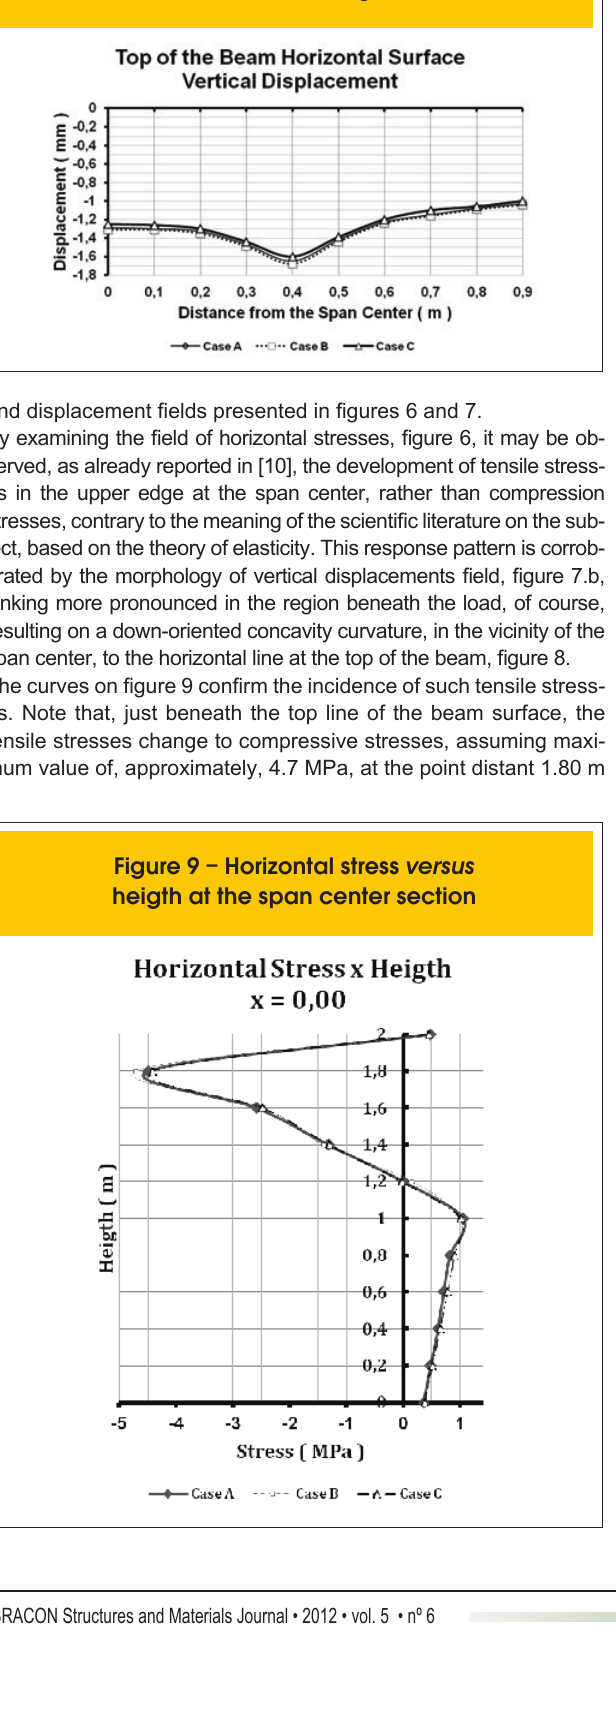
Figure 8 – Top of the beam horizontal line deformed configuration